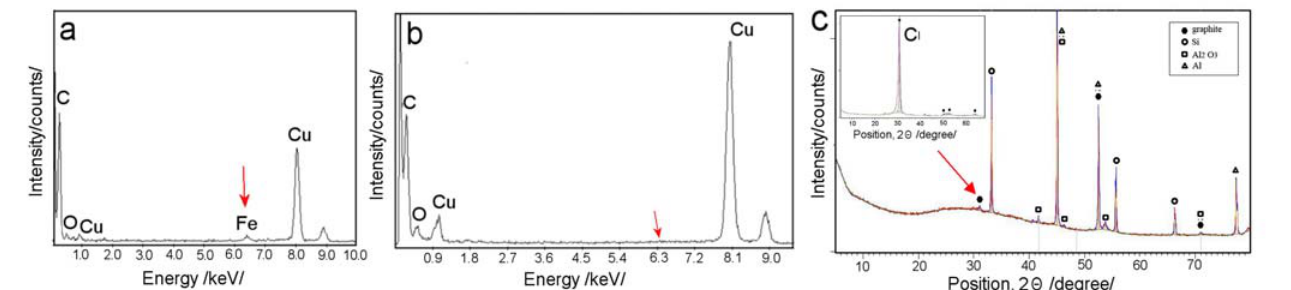
Figure 6. EDX analysis of CNT synthesised in PA with catalyst (ferrocene/toluene) carbon precursor taken from (a) the top of the PA surface and (b) the inside of PA pores and (c) XRD spectrum CNT inside of PA that indicates a small carbon peak (arrow). Inset shows XRD spectrum of CNT liberated from PA template that shows very strong carbon peak